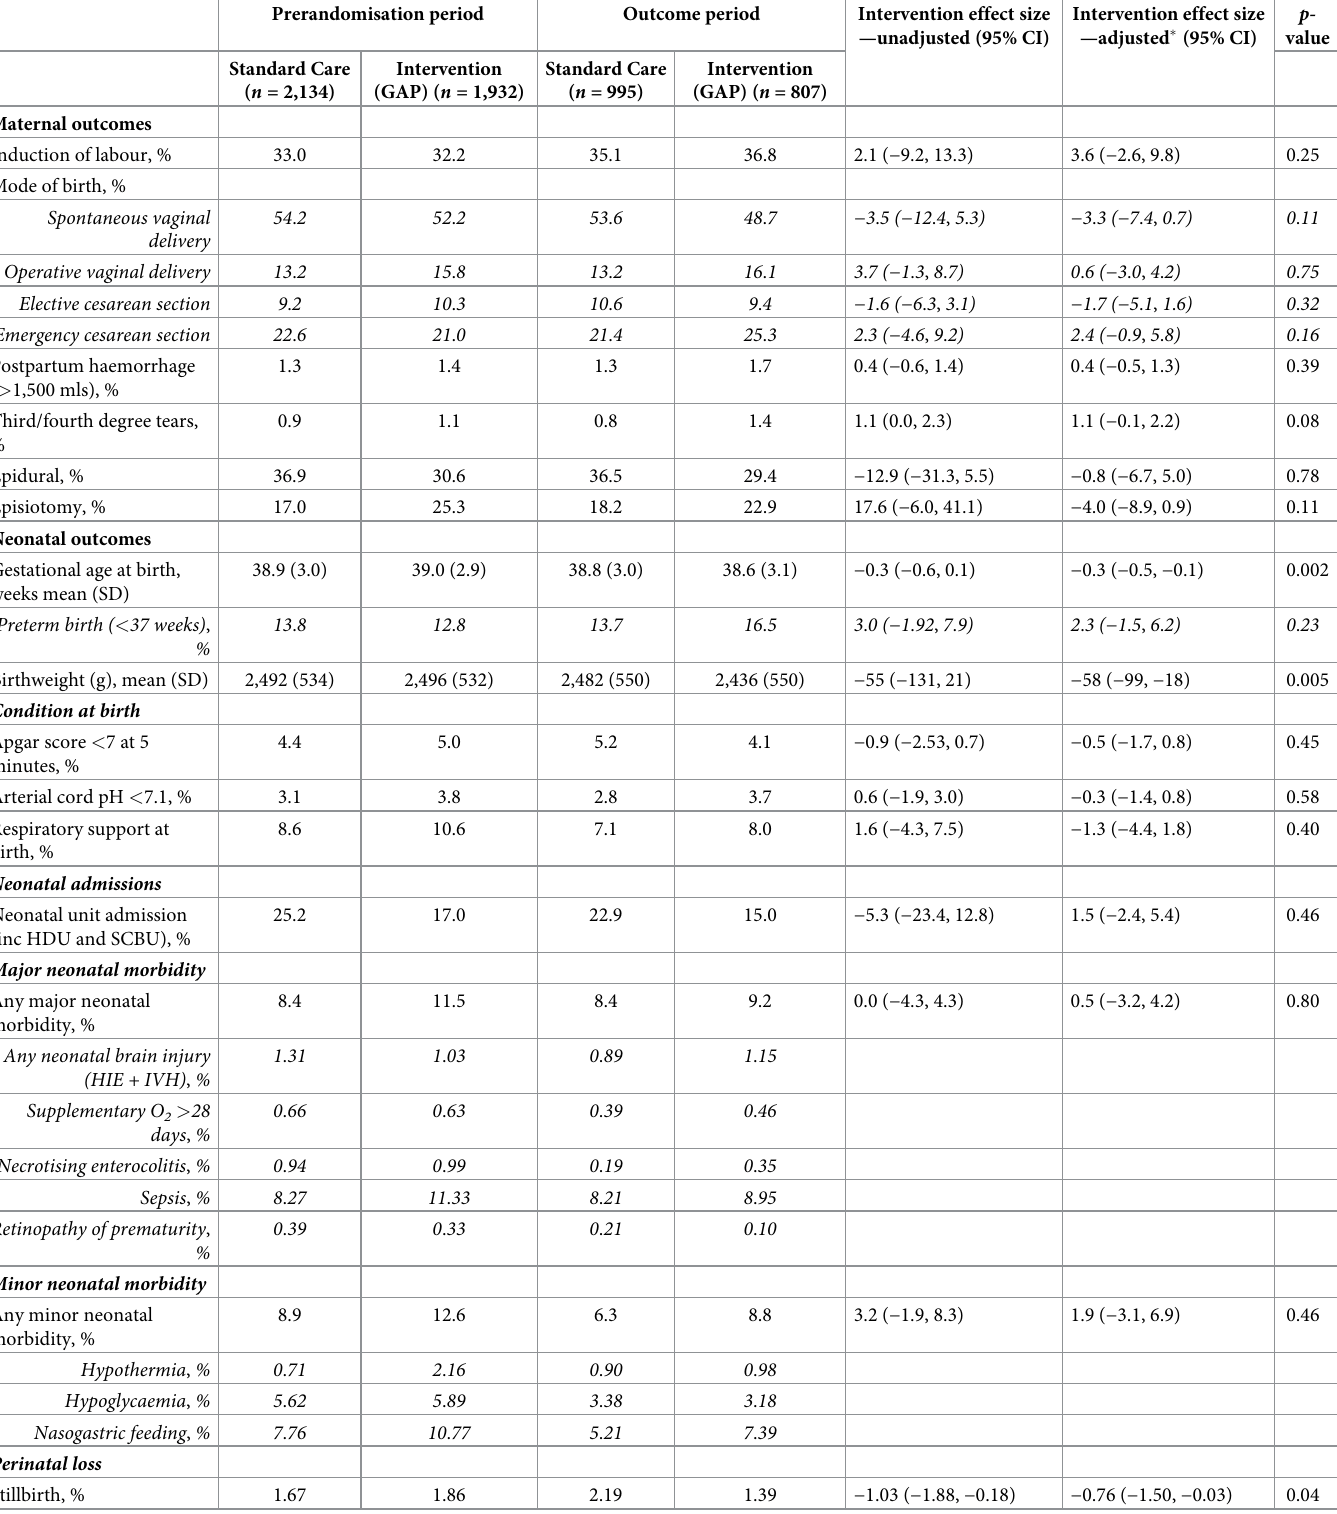
Table 6. Subgroup analysis: Clinical outcomes among SGA babies by population and customised according to treatment allocation (mITT analysis). Prerandomisation